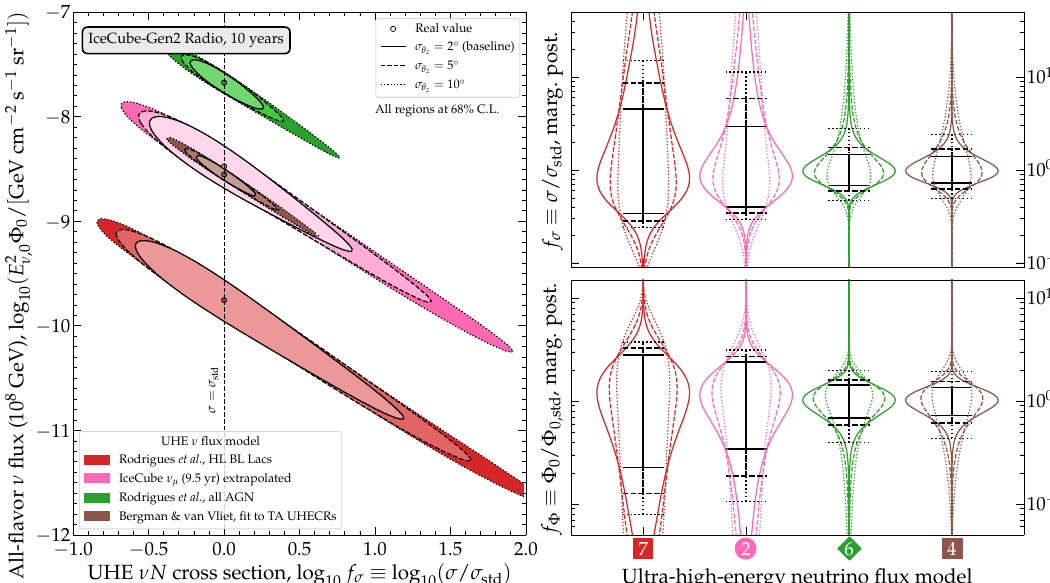
, on the measurement of the νN DIS z